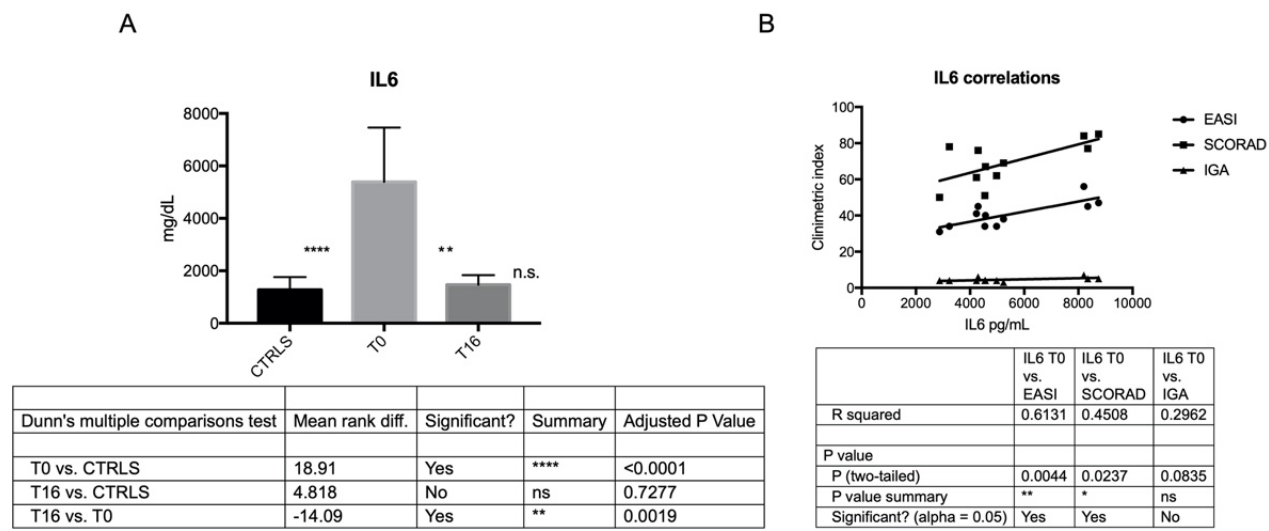
Figure 4. IL6 secretion by C- and AD-MSCs at T0 and T16 and its correlation with AD severity at baseline. ( A ) The histogram depicts the level of secreted IL6 in C-MSCs and in AD-MSCs at T0 and at T16. Secreted protein, evaluated in triplicates by ELISA test, has been reported as pg/mL. ****: p < 0.0001, AD-MSCs T0 vs. C-MSCs; **: p = 0.0019, AD-MSCs T0 vs. AD-MSCs T16. ( B ) Correlation between IL6 secreted by MSCs at baseline and AD severity according to EASI, SCORAD, and IGA. ** p = 0.0044; * p = 0.0237.